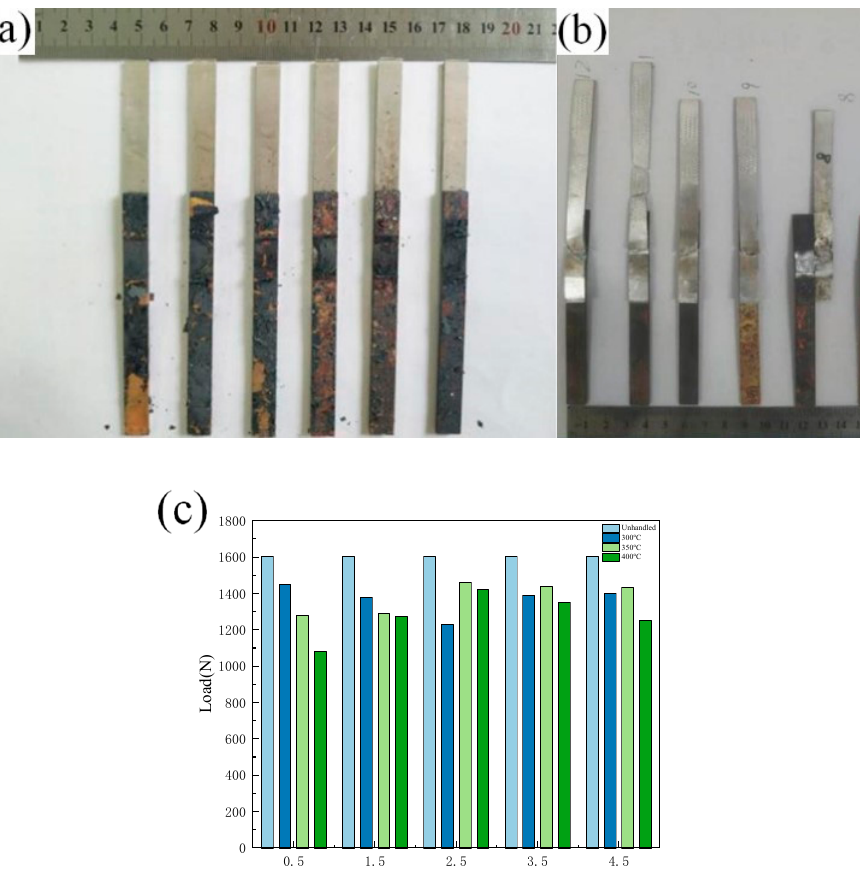
Figure 11. Tensile specimen and tensile strength after annealing treatment: ( a ) Tensile specimen before test; ( b ) Tensile specimen after test; ( c ) Strength of tensile specimen after annealing treatment.